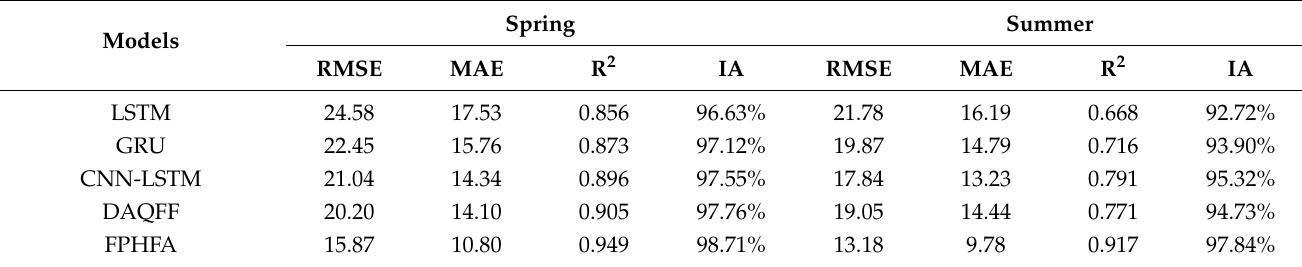
Table 4. The model performance evaluation indicators of models in spring and